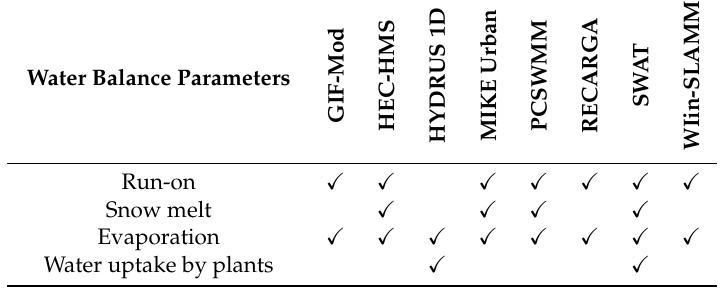
Table 7. Comparing the water balance model parameters of the selected models.